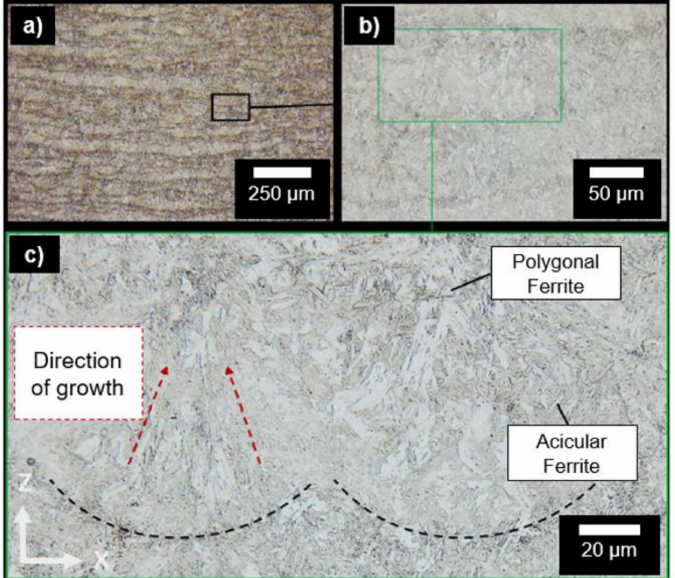
Figure 1. Microstructure of as-built 16MnCr5 with z indicating the build direction of the PBF-LB/M process, ( a ) 100 × magnification, ( b ) 500 × magnification, ( c ) digital